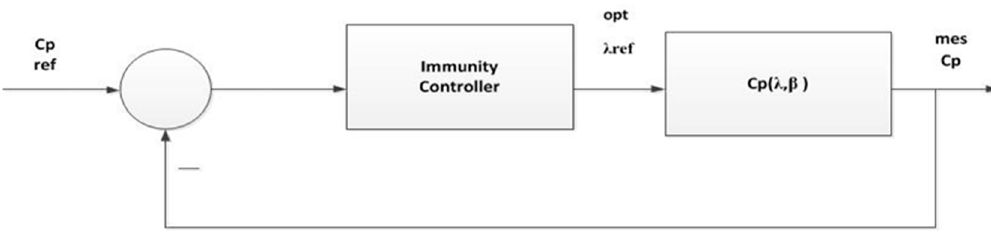
Figure 6. Structure of the Artificial Intelligent